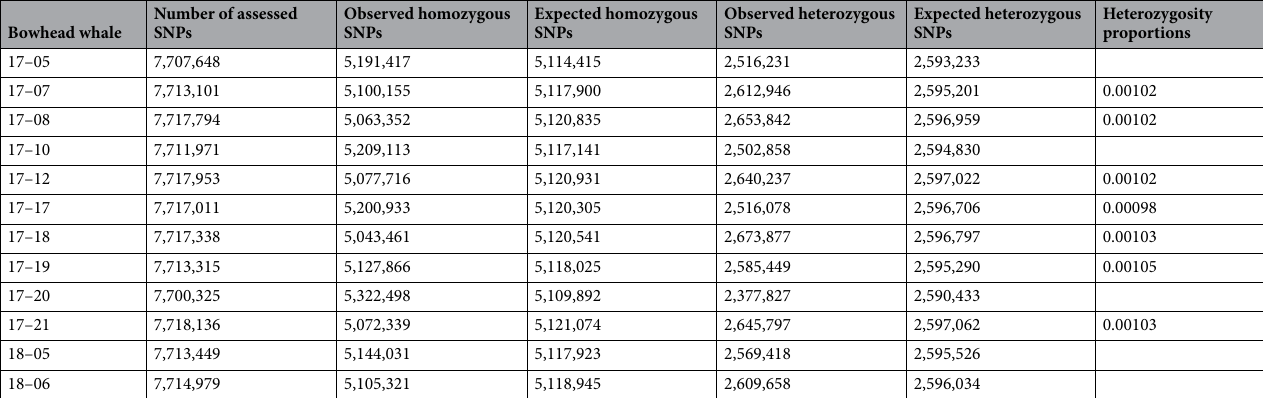
Table 1. Observed and expected numbers of homo- and heterozygous sites and autosome-wide heterozygosity proportions for the EGSB stock samples with an average coverage > 20 × calculated with ANGSD 32